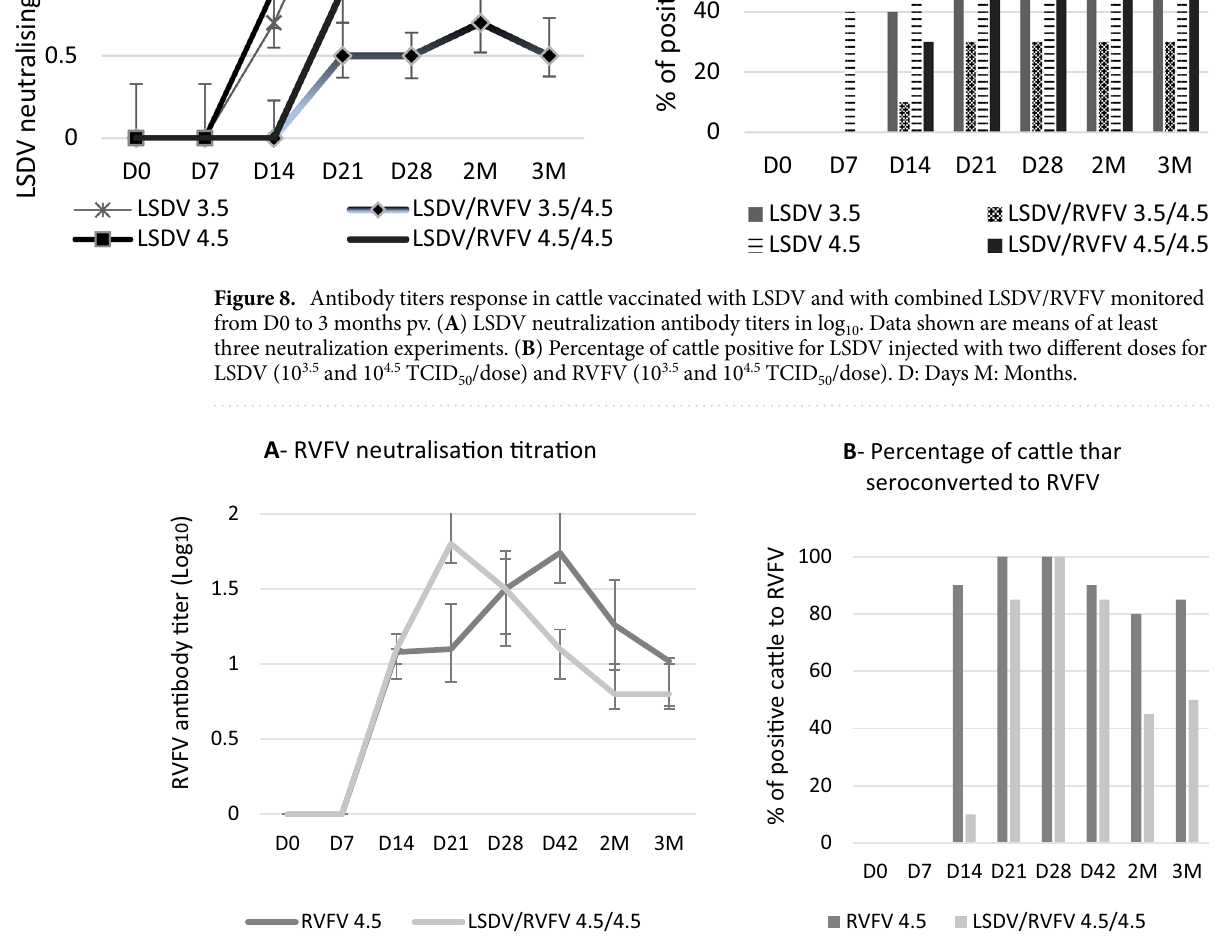
Figure 9. Antibody titers response in cattle vaccinated with RVFV alone, and with combined RVFV/LSDV vaccine. Cattle are monitored from D0 to 3 months pv. ( A ) RVFV neutralization antibody titers. Data shown are means of at least three neutralization experiments. ( B ) Percentage of cattle thar seroconverted to RVFV injected with a dose of 10 4.5 TCID 50 /dose and with a dose of LSDV/RVFV 10 4.5 TCID 50 /dose. D: Days M: Months.